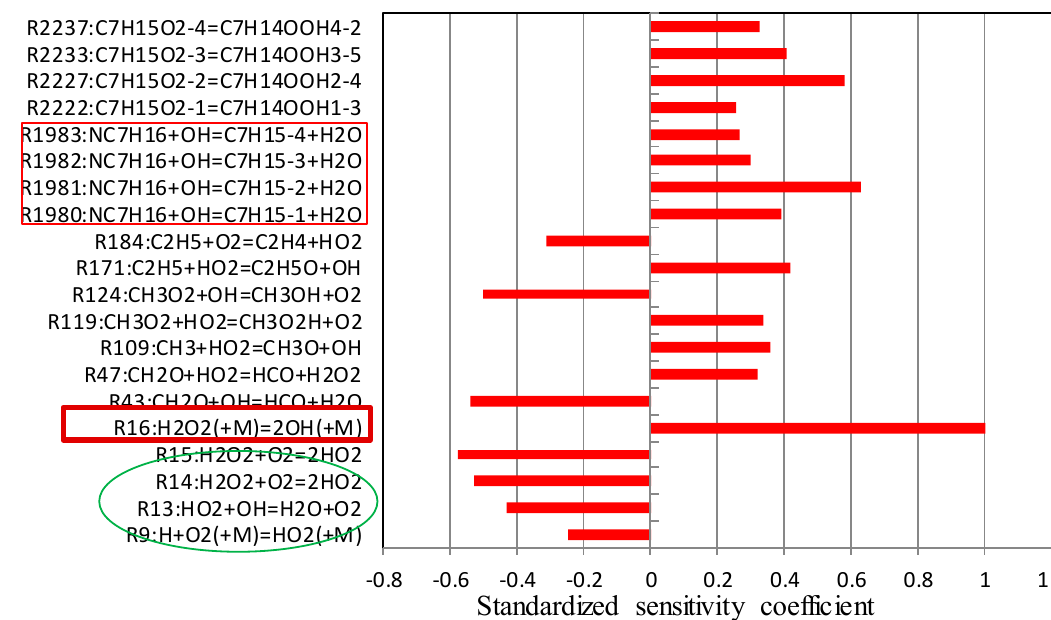
Figure 12. OH sensitivity analysis of N-heptane in the condition of 900 K.